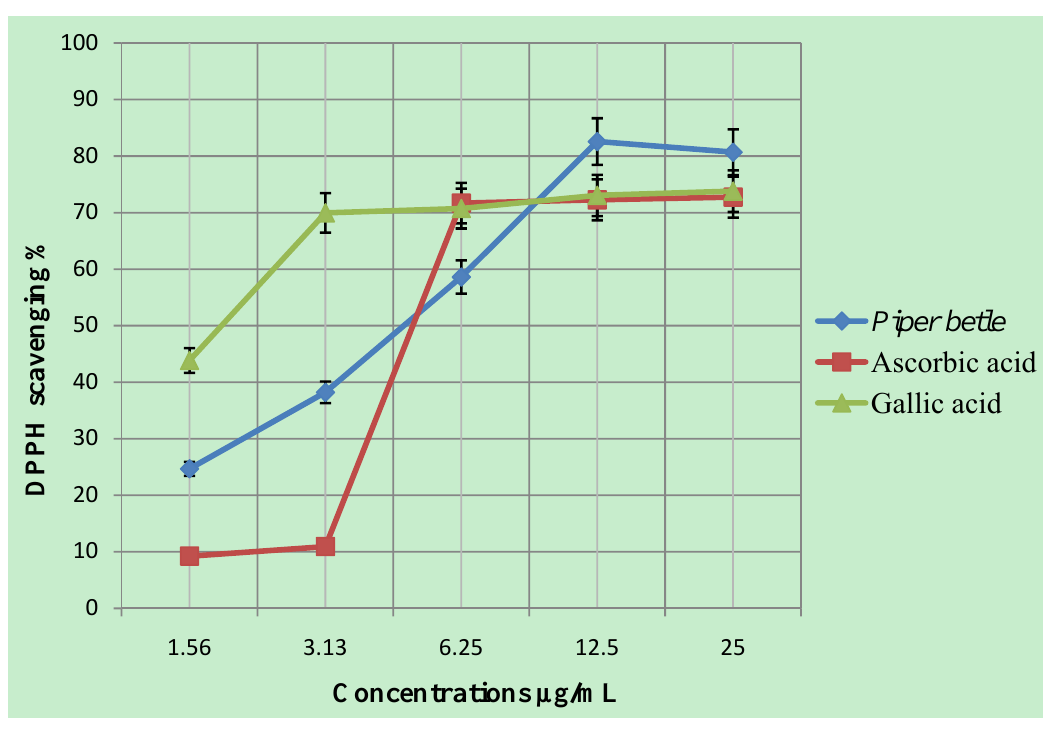
Figure 1. DPPH radical scavenging activity of methanol extract of Piper betle leaves. Absorbance values represent means of triplicate tests of the different concentrations